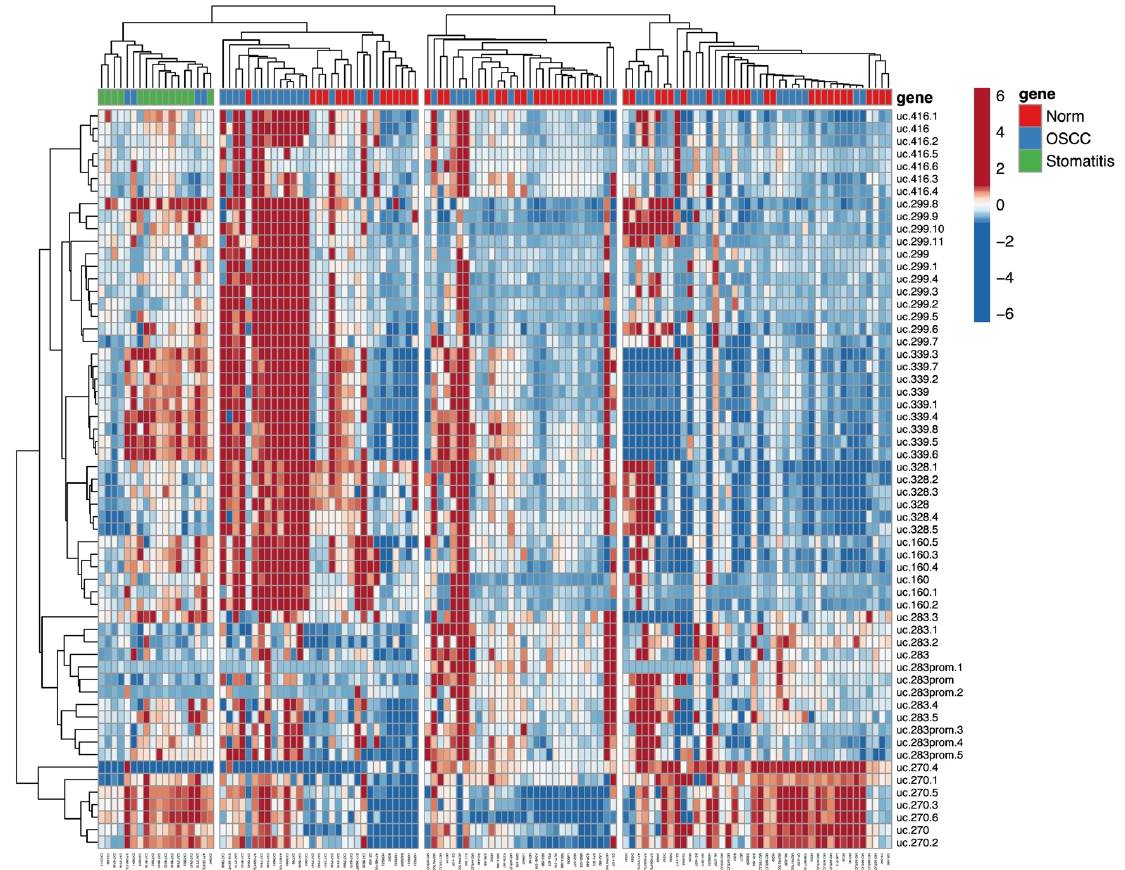
Figure 5. HeatMap evaluating DNA methylation levels of all CpGs and all samples investigated. Values in the matrix are color-coded, and rows (CpGs) and columns (specimens) are clustered using correlation distance and average linkage. Four clusters are marked: starting from the left, cluster 1 comprised all the feline stomatitis and 4 feline SCCs; cluster 2 comprised 17 SCCs (14 cats, 1 horse, 1 porcupine, 1 badger) and 14 normal samples (7 cats, 1 human, 4 horses, 1 bovine, 1 badger); cluster 3 included 10 human SCCs and 20 normal human oral mucosa samples; finally, cluster 4 included 18 SCCs (15 humans, 3 dogs), and 24 normal samples (16 humans, 5 dogs, 1 horse, 1 bovine). The following circle plot (Figure 6) represents graphically how the methylation level increases from normal donors, through stomatitis to SCC depending on the position of each CpG within the UCNE in humans, cats, and dogs.